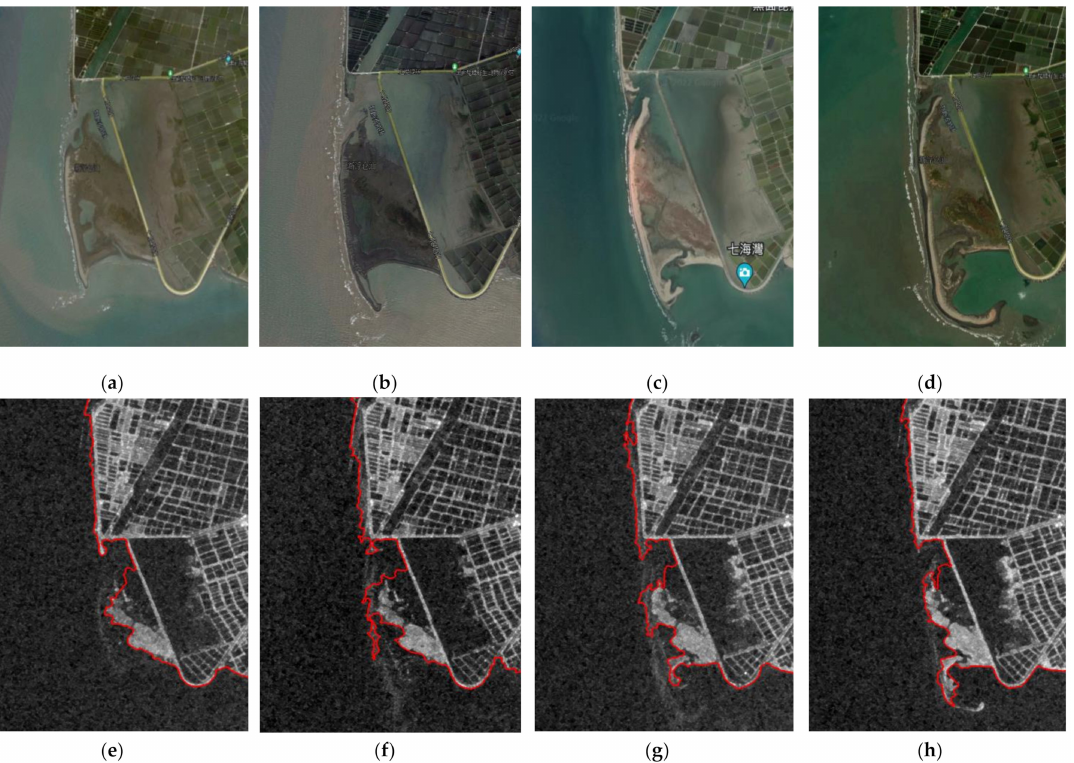
Figure 9. The changes of shoreline in Xinfu Lunshan sandbar from 2016 to 2021. The red border represents the detection results. ( a ) 2016 optical image; ( b ) 2018 optical image; ( c ) 2020 optical image; ( d ) 2021 optical image; ( e ) 2016 Sentinel-1 image; ( f ) 2018 Sentinel-1 image; ( g ) 2020 Sentinel-1 image; ( h ) and 2021 Sentinel-1 image.